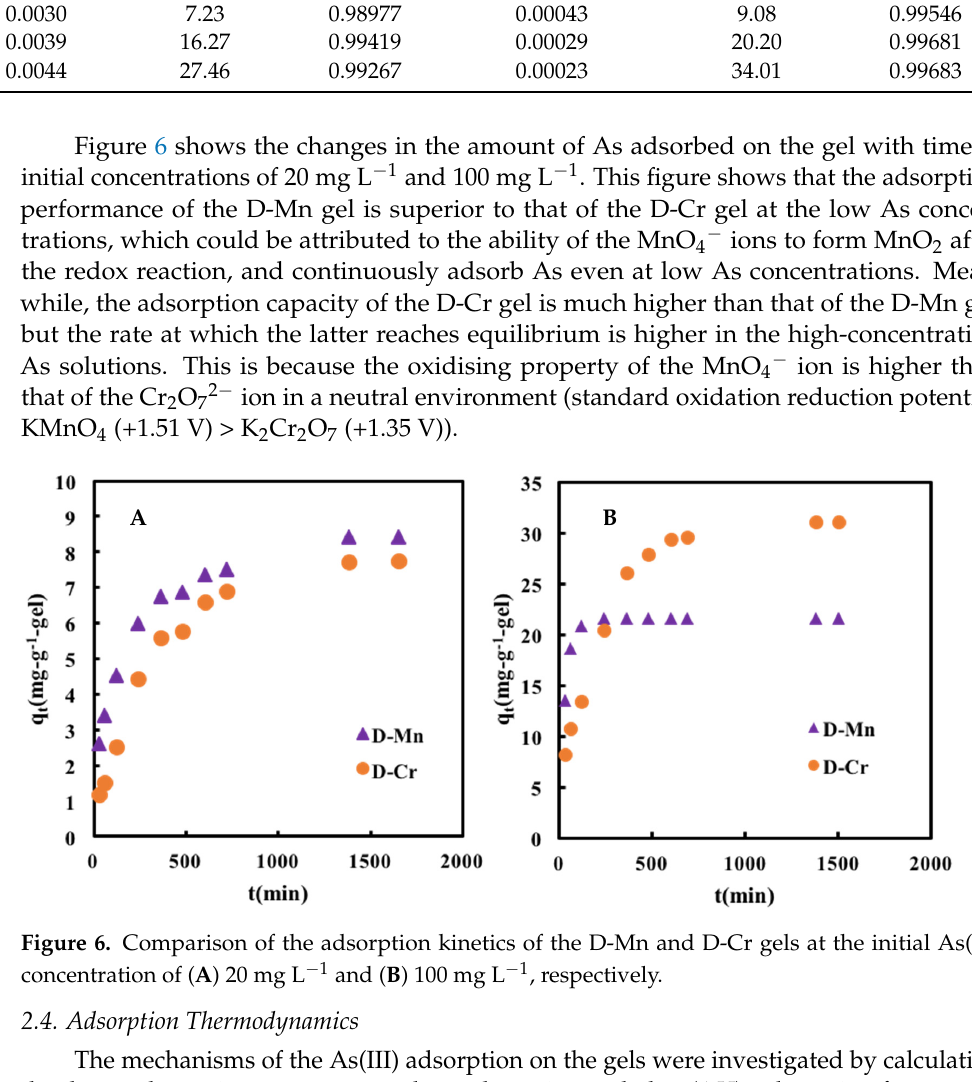
Table 5. Kinetic parameters of As(III) adsorption by the D-Cr gel.